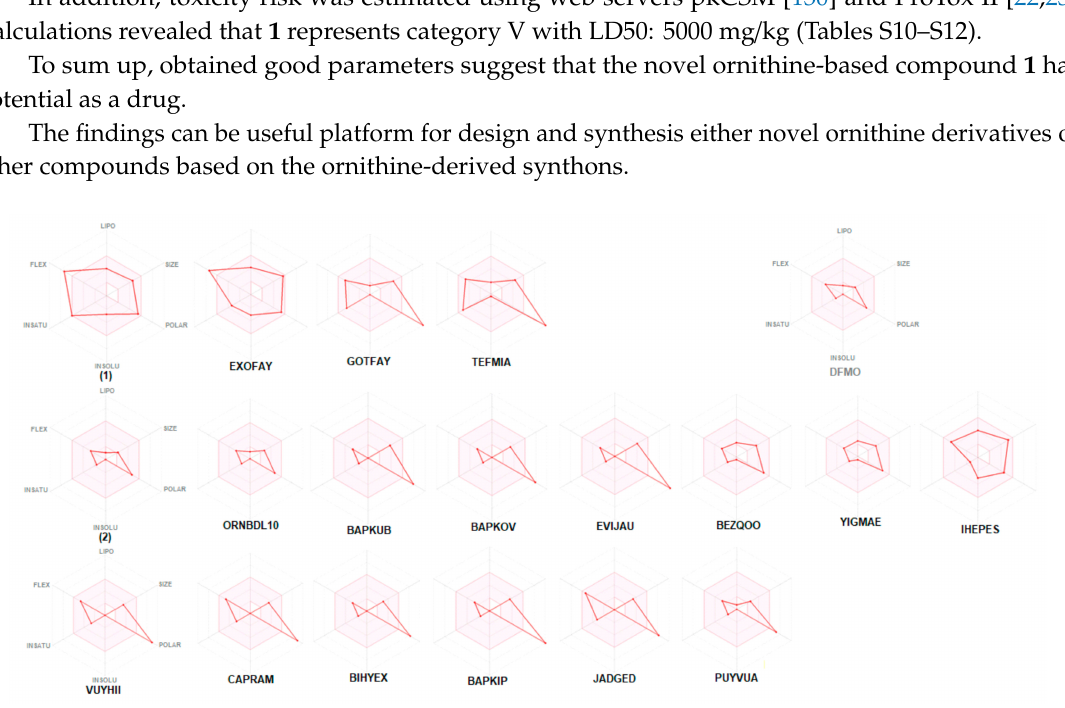
Table 3. Pharmacological profile, medicinal chemistry principles and lead-likeness properties of 1 . Physicochemical Properties Table 1. Crystallographic data and structure refinement parameters for 1 . Chemical Formula